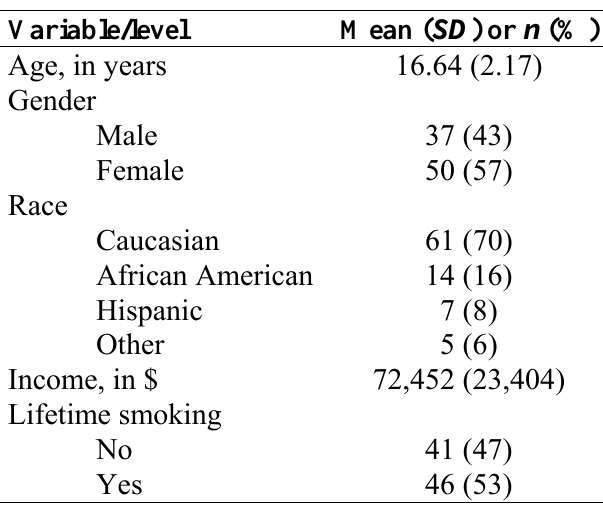
Table 2. Demographic characteristics ( n =